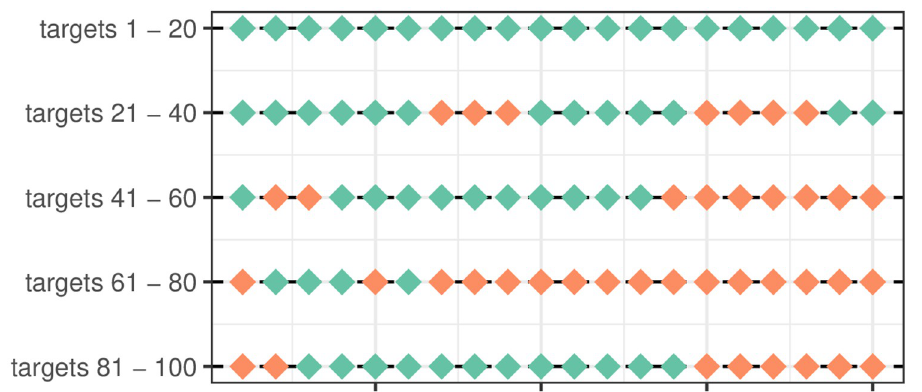
Fig 1. Example data from Dawkins (1971). The first 100 grains taken by one chick in experiment 1.